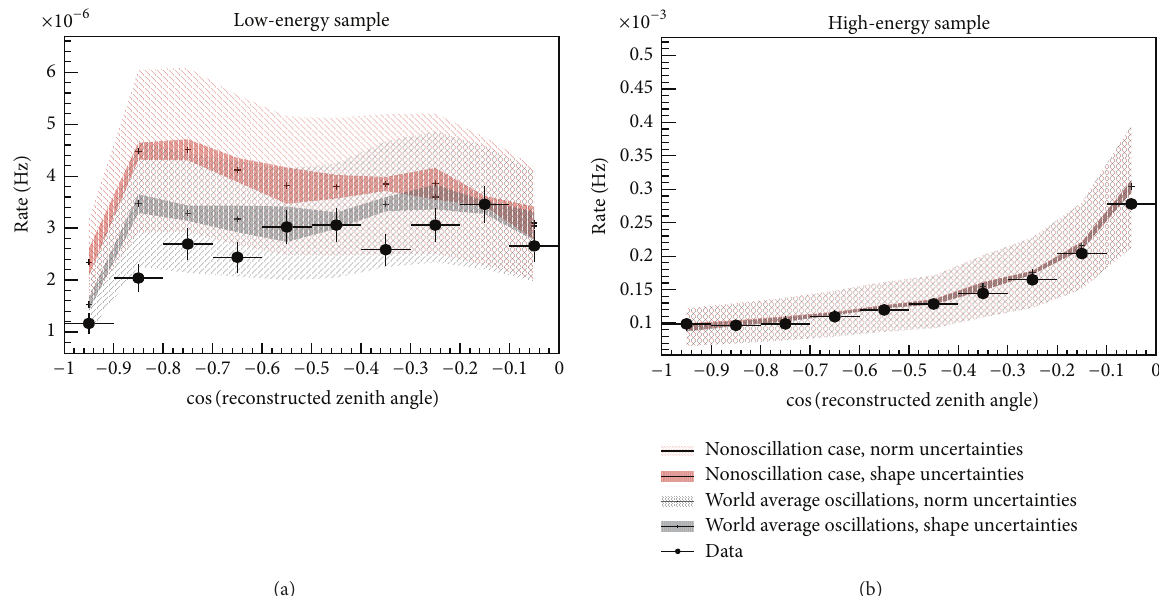
Figure 3: Data and Monte Carlo expectation at world average oscillation parameters [4] and at the nonoscillation scenario for the low-energy sample (a) and for the high-energy sample (b). The shaded bands illustrate separately those systematic effects which affect the normalisation (norm) and the shape (shape) of the distributions (figure from